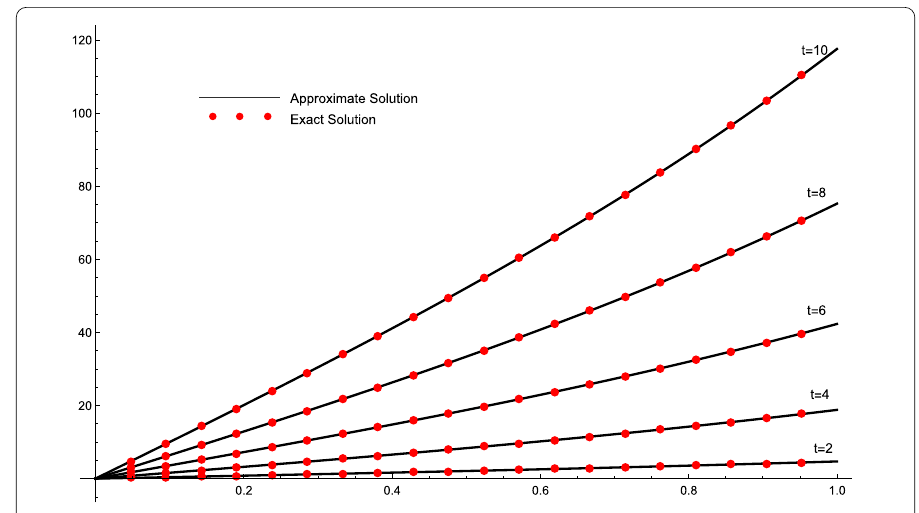
Figure 7 Exact and approximate solutions for Example 3 at t = 2,4,6,8,10 when N = 10, α = 1.5 and (cid:11) t = 0.01